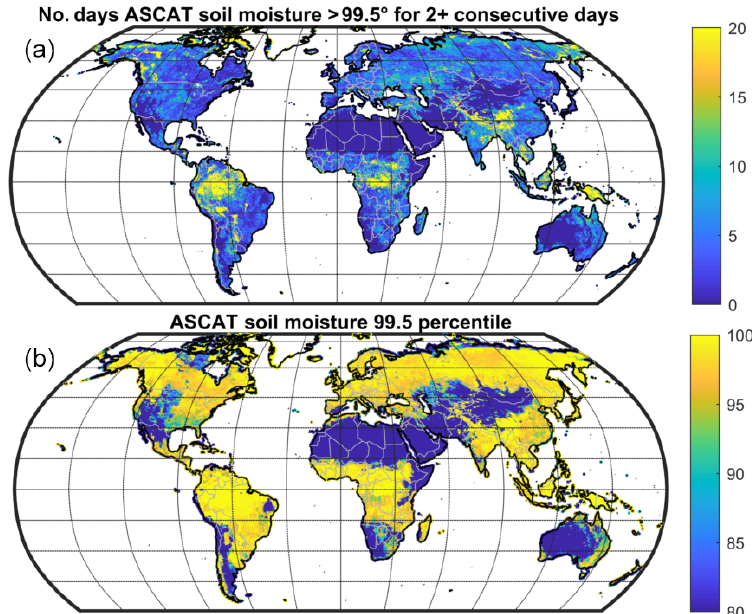
Figure A2. Number of days in which ASCAT soil moisture observations are close to saturation ( > 99.5 percentile, a ) for 2 (or more) consecutive days in the period 2007–2018. Please note that the upper value is set to 20d as in most of the land areas the occurrence is very low (90% of the land pixels have values lower than 12d over 12 years). In the bottom panel the soil moisture values in the 99.5 percentile (in the period 2007–2018) are